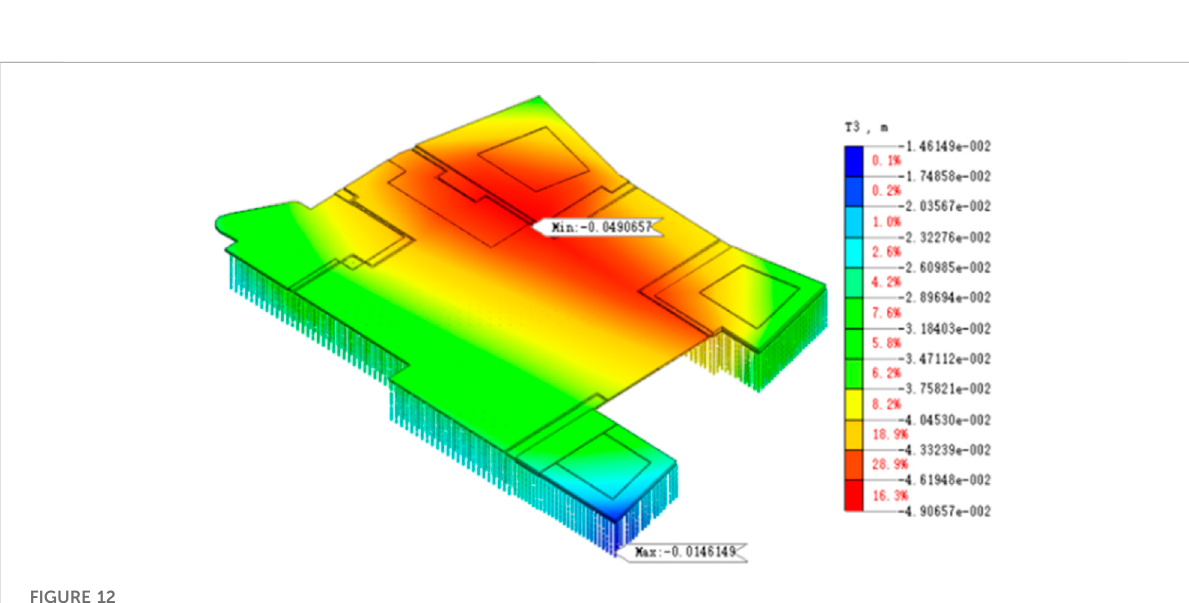
FIGURE 12 Contour diagram of settlement of late poured